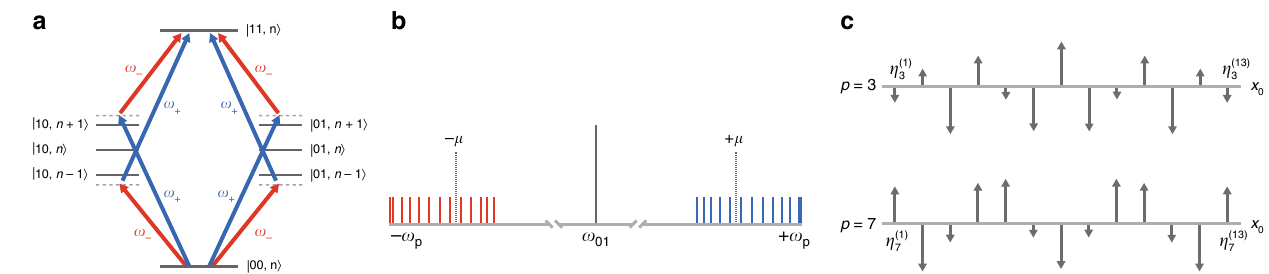
Fig. 1 Quantum dynamics of an EASE gate. a An energy-level diagram associated with the p th motional mode showing off-resonant red and blue sideband transitions that cause the desired two-qubit coupling between 00 j i and 11 j i quantum states. Here, ω ± = ω 01 ± μ , and n denotes the motional state. b Frequency spectrum of the motional modes ω p of the ion chain centered around the carrier frequency ω 01 that induces a single-qubit state transition. Symmetric detuning by frequency μ for red and blue sidebands is applied to the pulses that illuminate ions to induce the desired EASE gate. c Motional- mode diagrams that show the geometric structure of the modes. The ion displacements from their respective equilibrium positions are proportional to the coupling strength η ð m Þ p between the different ions m and the different modes p .